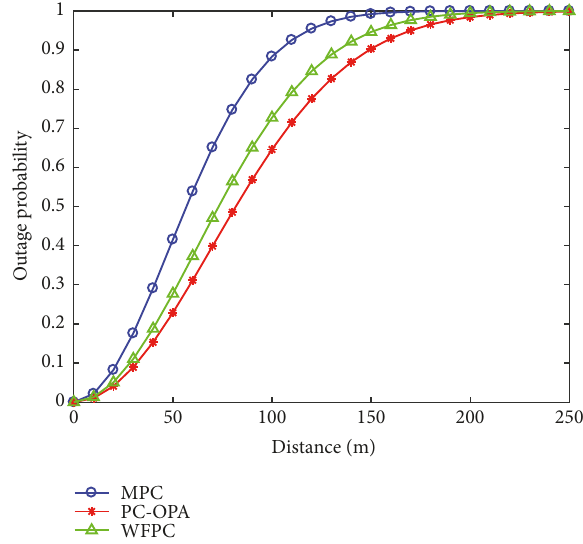
Figure 7: Outage probabilities versus